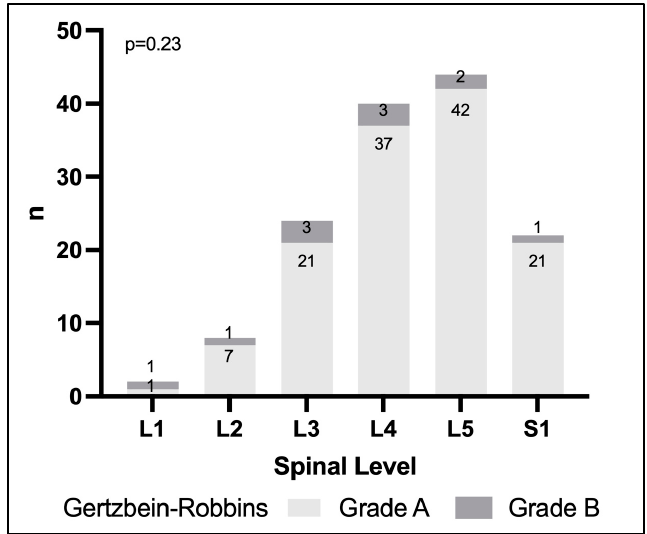
Figure 6. Qualitative evaluation of final screw position according to the Gertzbein–Robbins classifica- tion across spinal levels treated. There were no differences in qualitative screw results across spinal levels ( p =